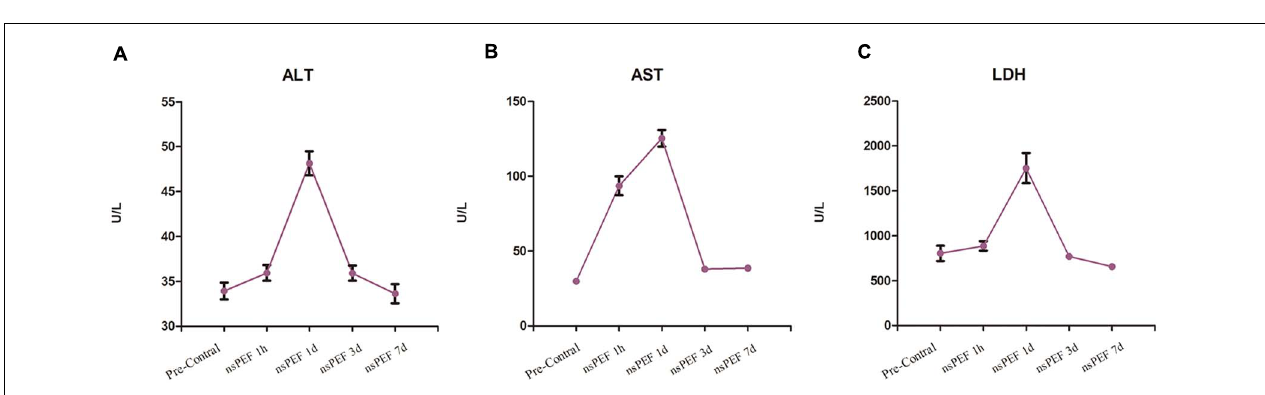
FIGURE 1 | Study design: This study involves 10 pigs. Blood samples were collected from all 10 pigs at all time points, and faecal samples were completely collected from seven of the pigs.